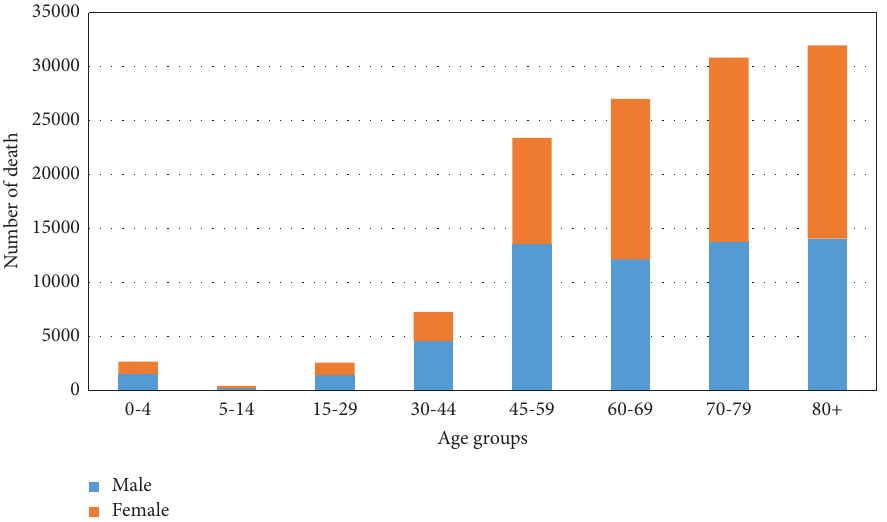
Figure 2: YLL due to hypertension based on gender and age